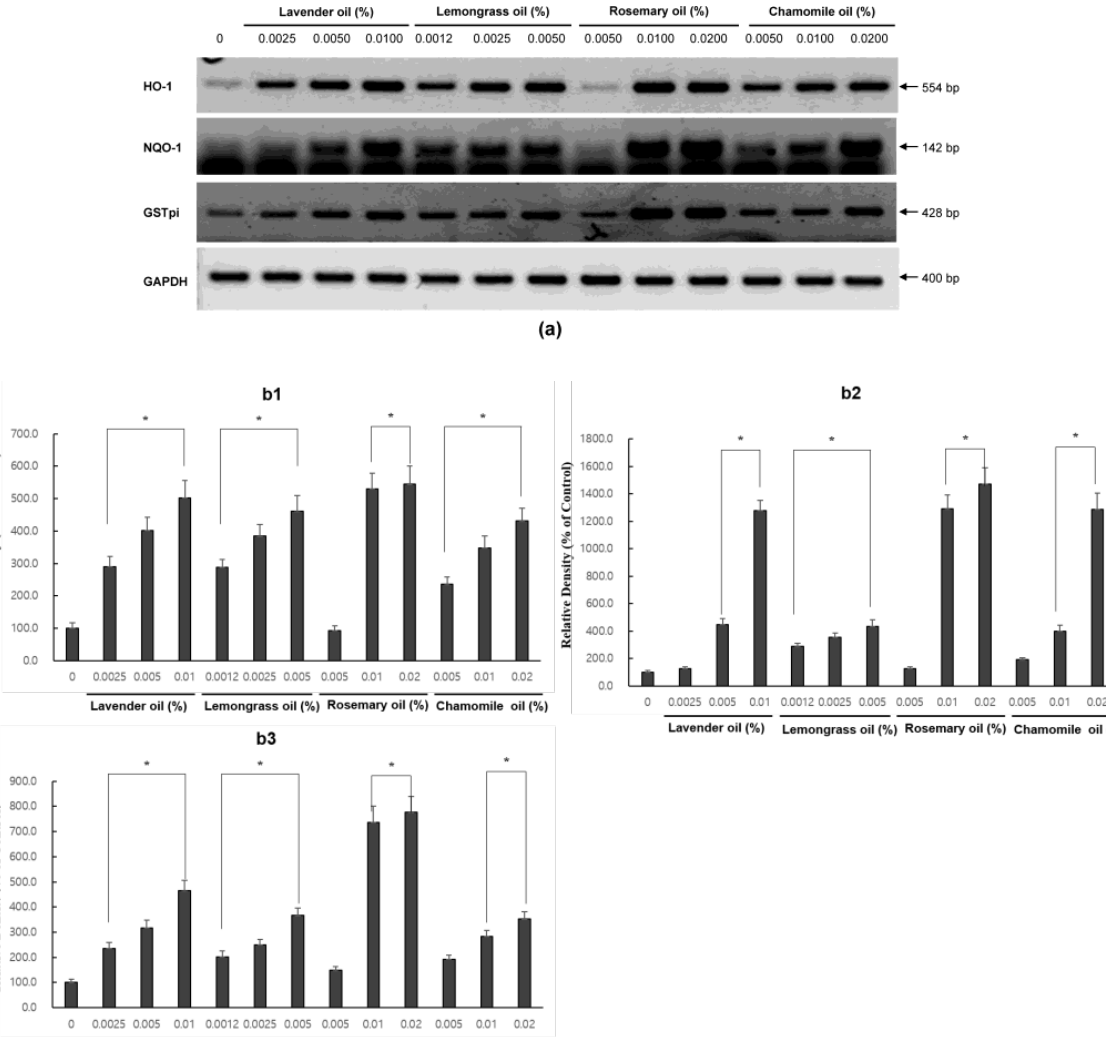
Figure 4. Dose-dependent induction of the mRNA expression of phase II enzymes in essential oils-treated DPC. ( a ) The DPCs were treated with lavender oil (0.025–0.01%), lemongrass oil (0.0012–0.005%), rosemary oil (0.005–0.02%), and chamomile oil (0.005–0.02%). The figure shows representative results from triplicate RT-PCR experiments. ( b ) Phase II enzymes mRNA level are quantified by densitometric analysis * p < 0.05,